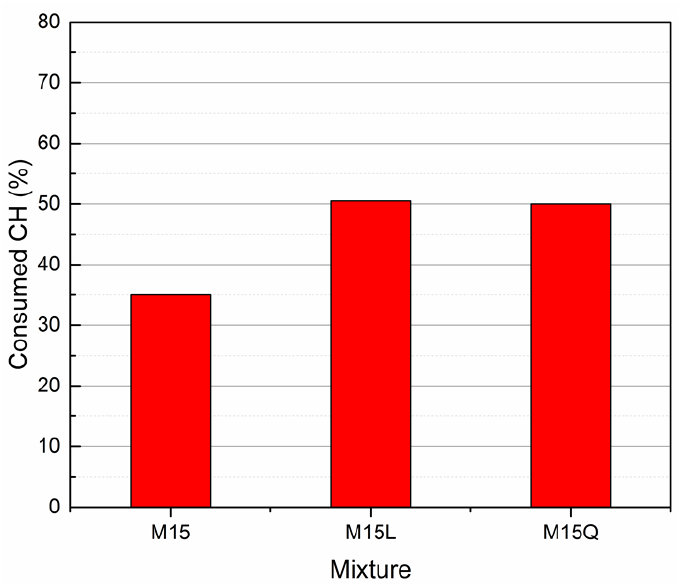
Figure 8. Consumed Calcium Hydroxide in the paste fraction of mixtures M15, M15L and M15Q after 91 days of standard curing.